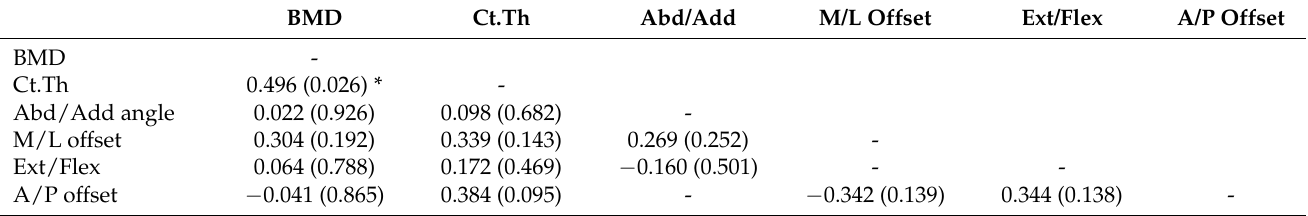
Table 3. Results of correlation analyses of interest, presented as the Pearson product–moment correlation coefficient with the corresponding p -value. Statistically significant correlations were highlighted with an asterisk